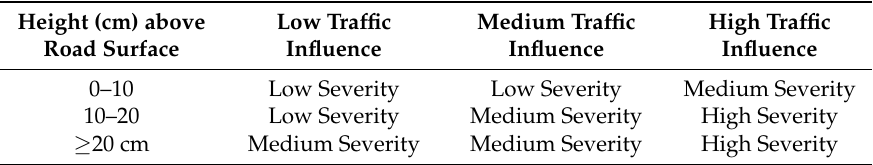
Table A1. Tree roots severity levels.